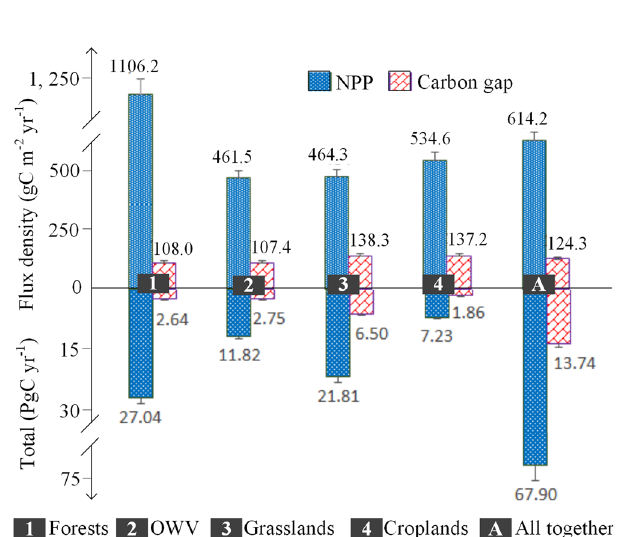
Fig. 3 Comparison of the carbon gap and NPP across biomes. The statistics summarize the carbon gap and NPP (total and fl ux) of the global vegetated area (see more on the de fi nition of the vegetated area in Supplementary Table 3).